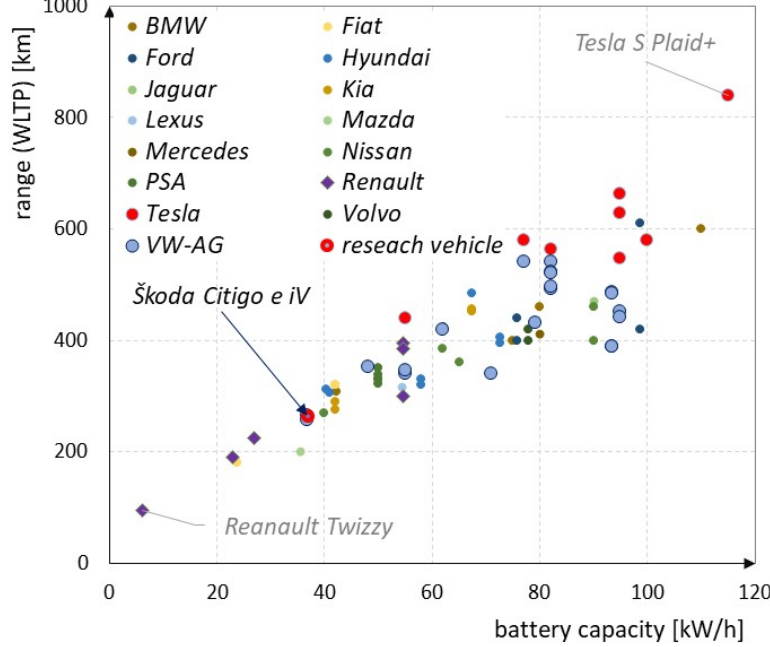
Figure 5. Range of electric vehicles in relation to battery capacity of manufacturers available in the Polish market (own draft based on [35]).